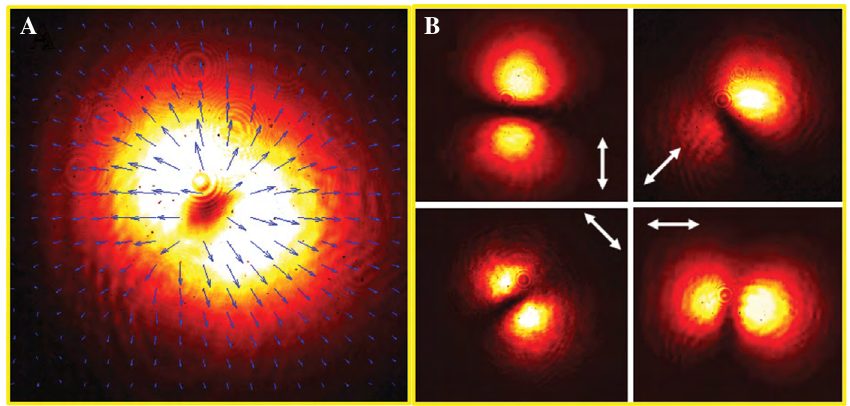
Figure 5 (A) CV beam generated at the fiber end with circularly polarized illumination. (B) CV beam passes through a linear analyzer ori- ented at different angles indicated by the arrows. Adapted from Ref. Adapted from Ref. [30].